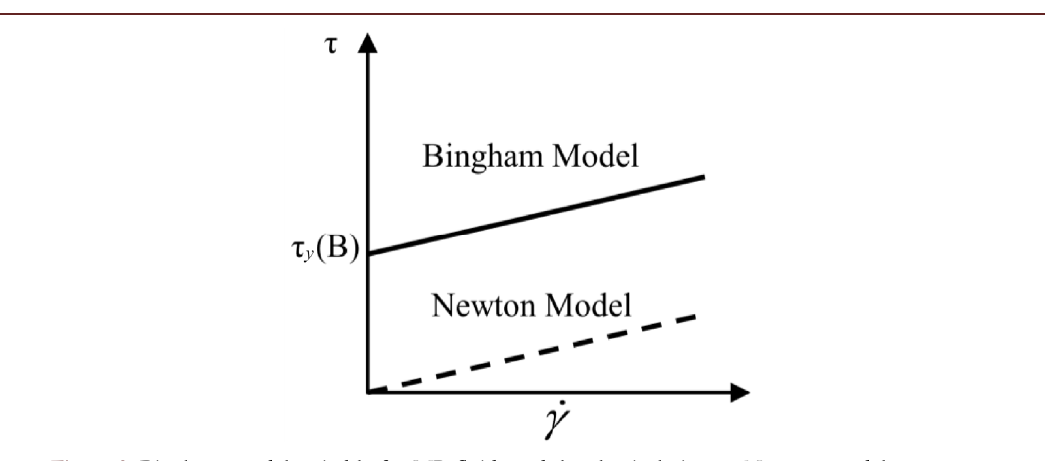
Figure 3: Bingham model, suitable for MR fluids and the classical viscous Newton